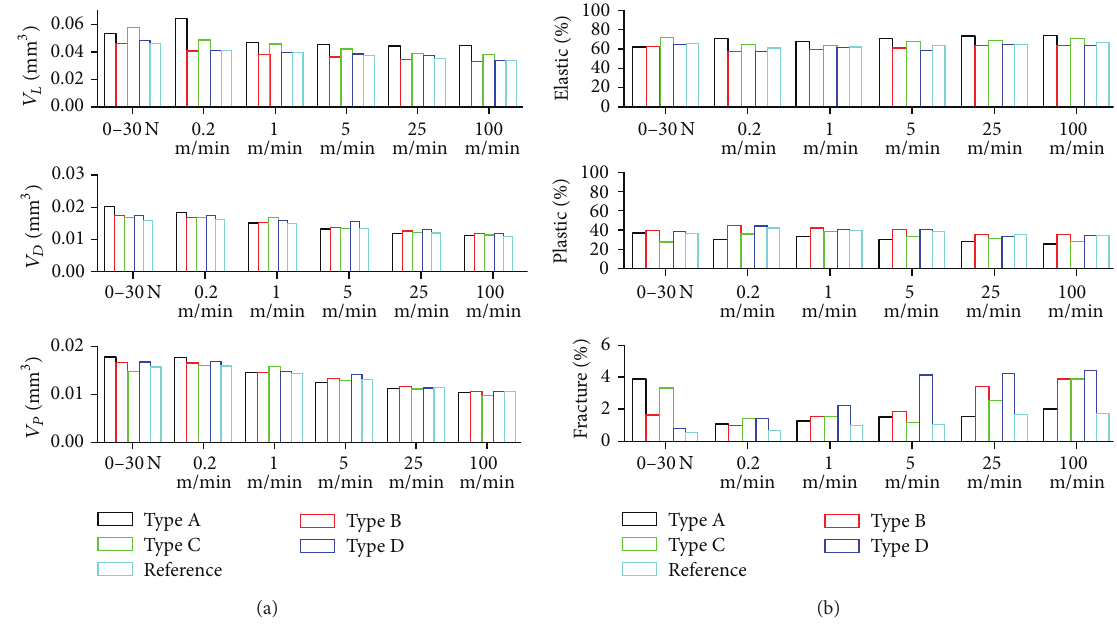
Figure 9: Analysis of residual scratch patterns: (a) volume of pile ( 𝑉 𝑃 ) and ditch ( 𝑉 𝐷 ); (b) deformation contributions.